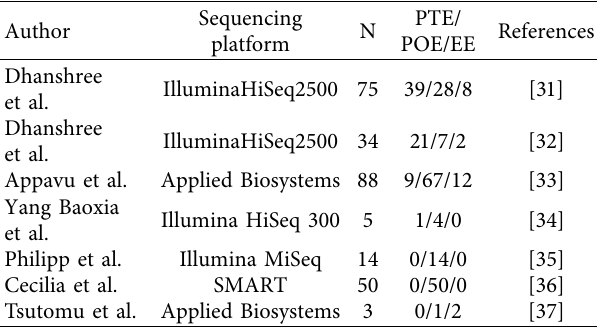
Figure 1: Development of sequencing technology and application in identifying the pathogens in endophthalmitis. Table 1: Sequencing studies related to infectious